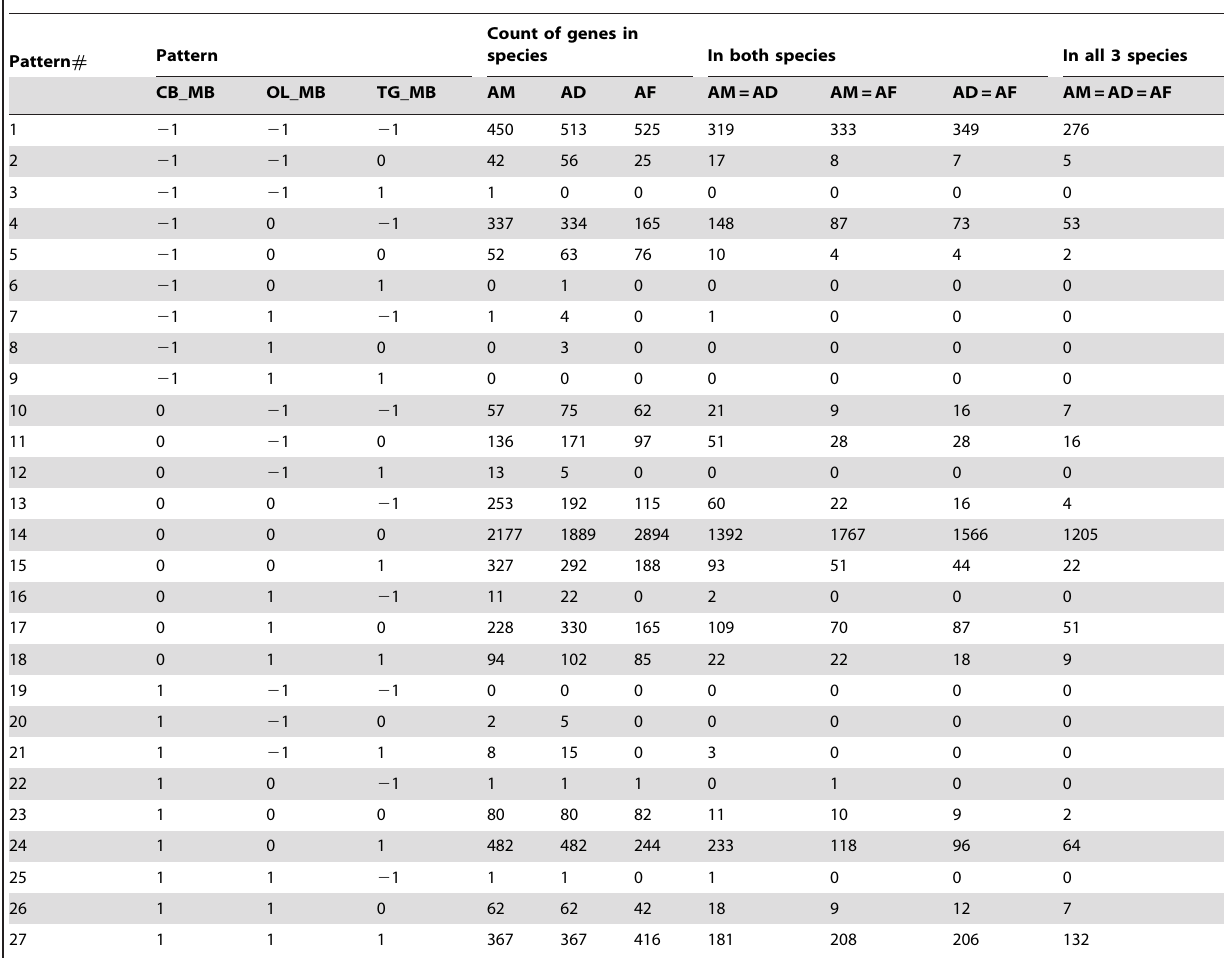
Table 1. The number of genes that showed each of 27 possible expression patterns.